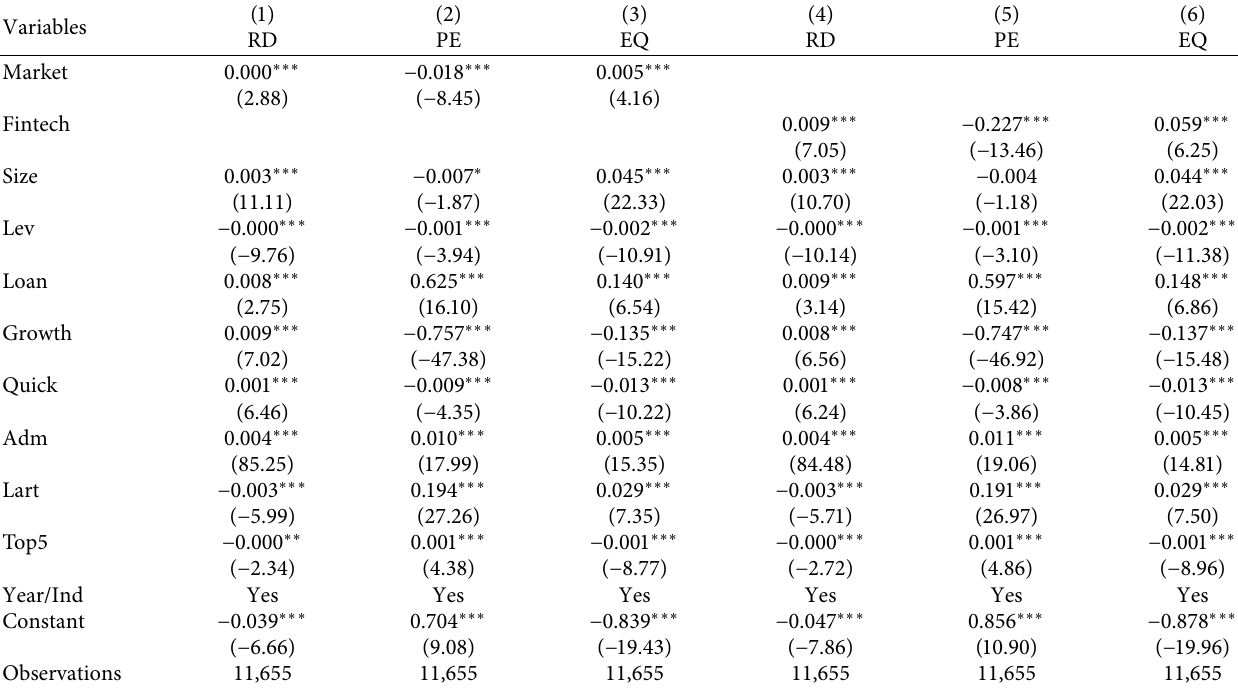
Table 6: Baseline regression